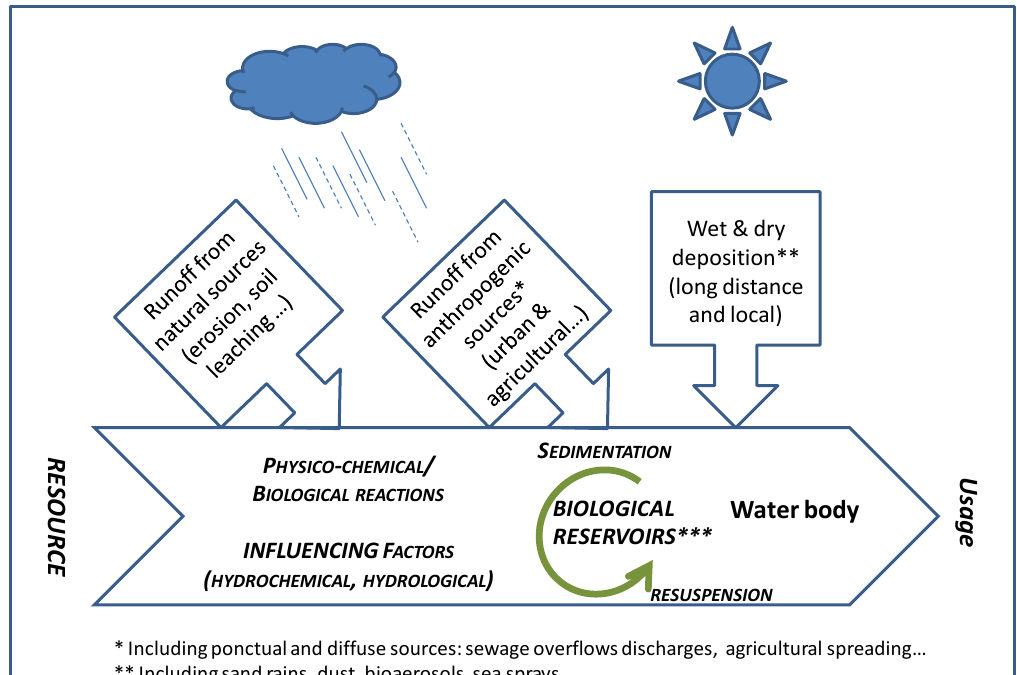
Figure 1. Schematic synthesis of source and fate of allochtonous microorganisms in